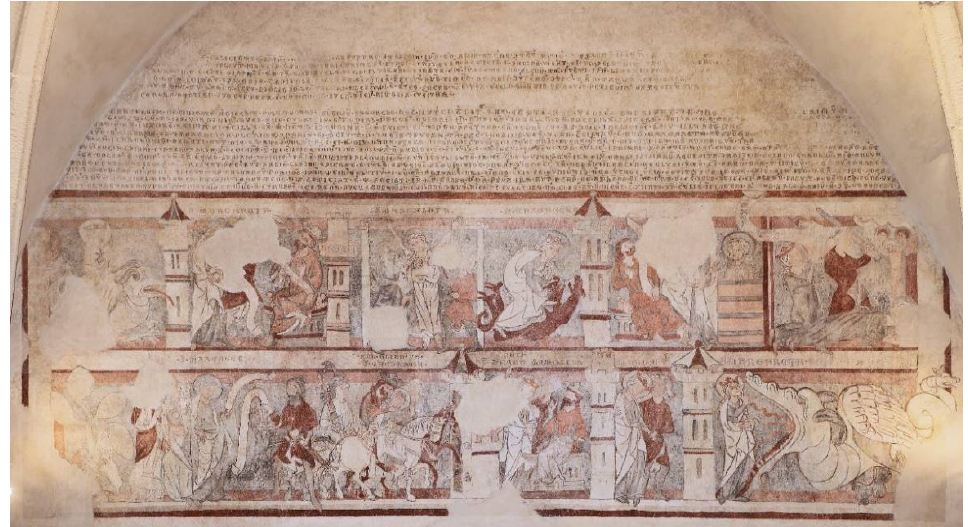
Figure 18. Velké Meziříčí, castle. Western wall with the cycle of St. Margaret of Antioch, first quarter of the 14th century. Photo by František Záruba, the author’s own work.